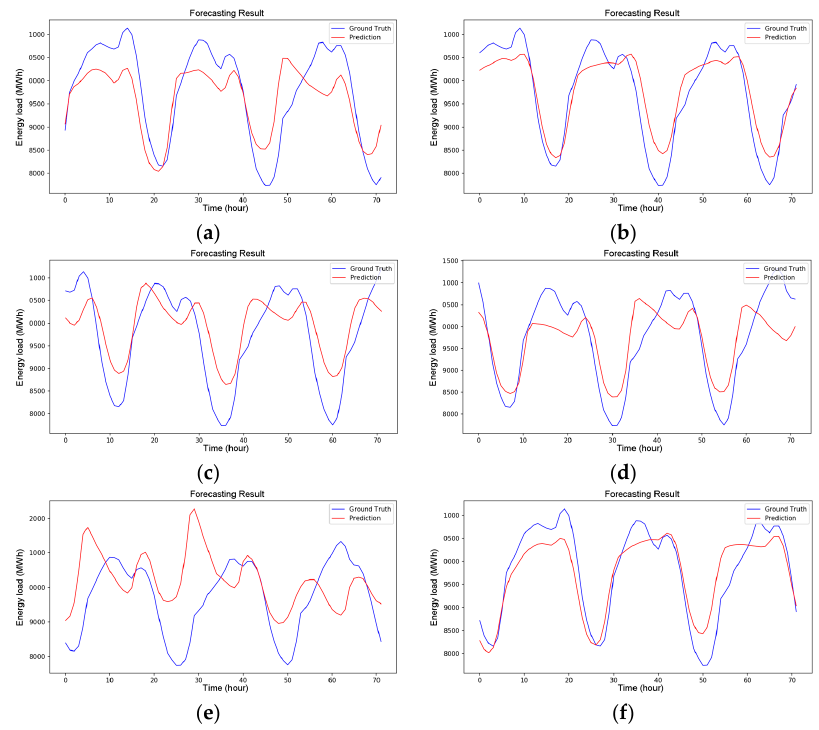
Figure 7. The forecasting results of random forest (RF): ( a ) Partial results A; ( b ) Partial results B; ( c ) Partial results C; ( d ) Partial results D; ( e ) Partial results E; ( f ) Partial results F.